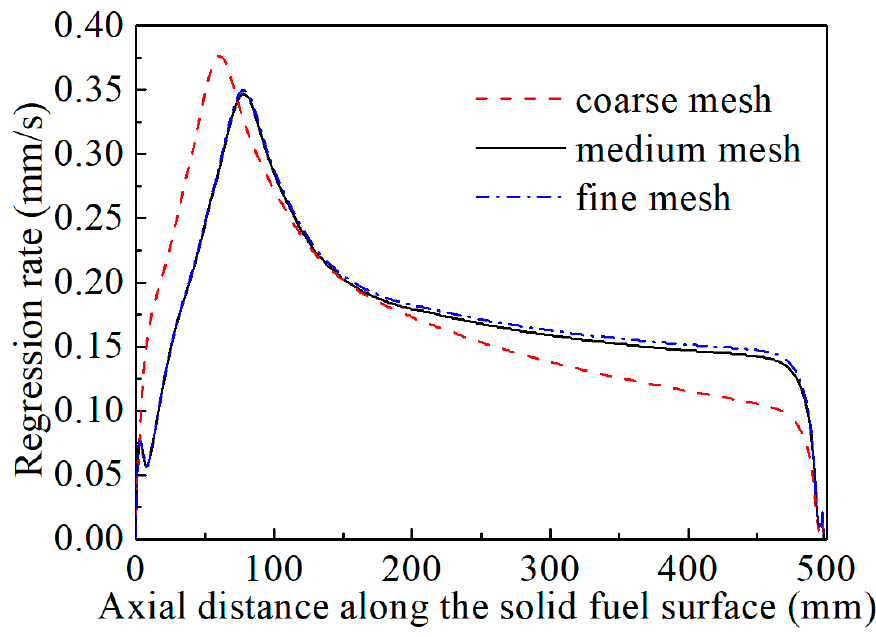
Figure 5. Axial distribution of local regression rate of different mesh number.